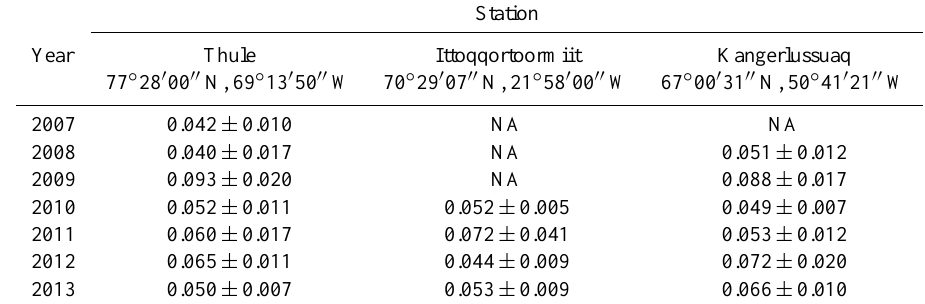
Table 2. June–July–August mean and standard deviation of measured aerosol optical depth (AOD) at 550nm at the three sites of Thule, Itto- qqortoormiit, and Kangerlussuaq of the AERONET network (AERONET website, http://aeronet.gsfc.nasa.gov, 2013). NA = not available.